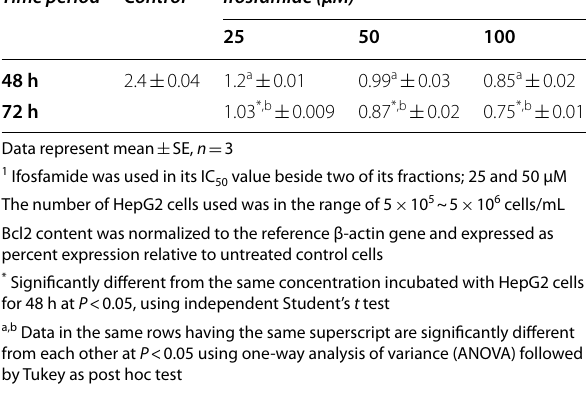
Table 7 Effects of ifosfamide on Bcl2 gene expression in HepG2 cells